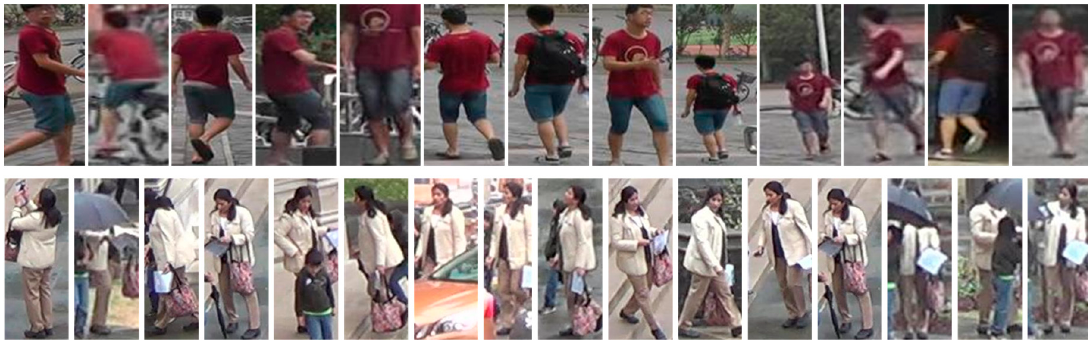
Figure 1. Examples of part misalignment caused by pose variation, background clutter, detection errors, camera point of view variation, different accessories and occlusion. Images in top row are from Market1501 dataset [8], and images in bottom row from DukeMTMC ‐ reID dataset [9].